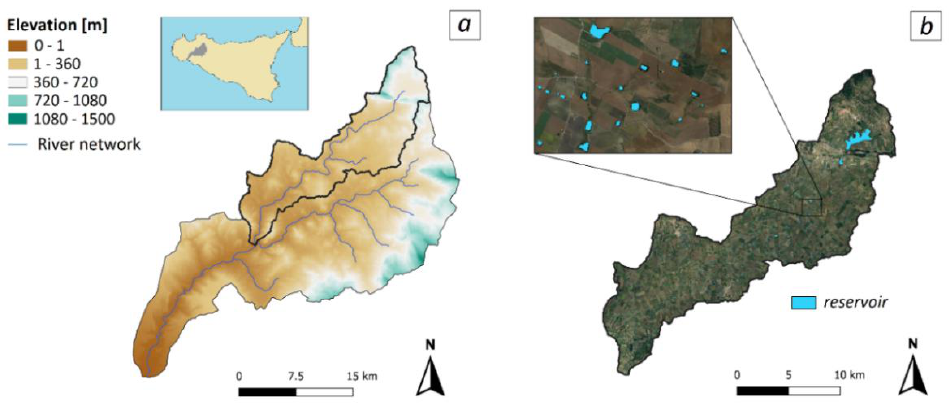
Figure 2. ( a ) Digital elevation model (DEM) of the Belice River basin and the analyzed subbasin and ( b ) map of reservoirs in the subbasin.